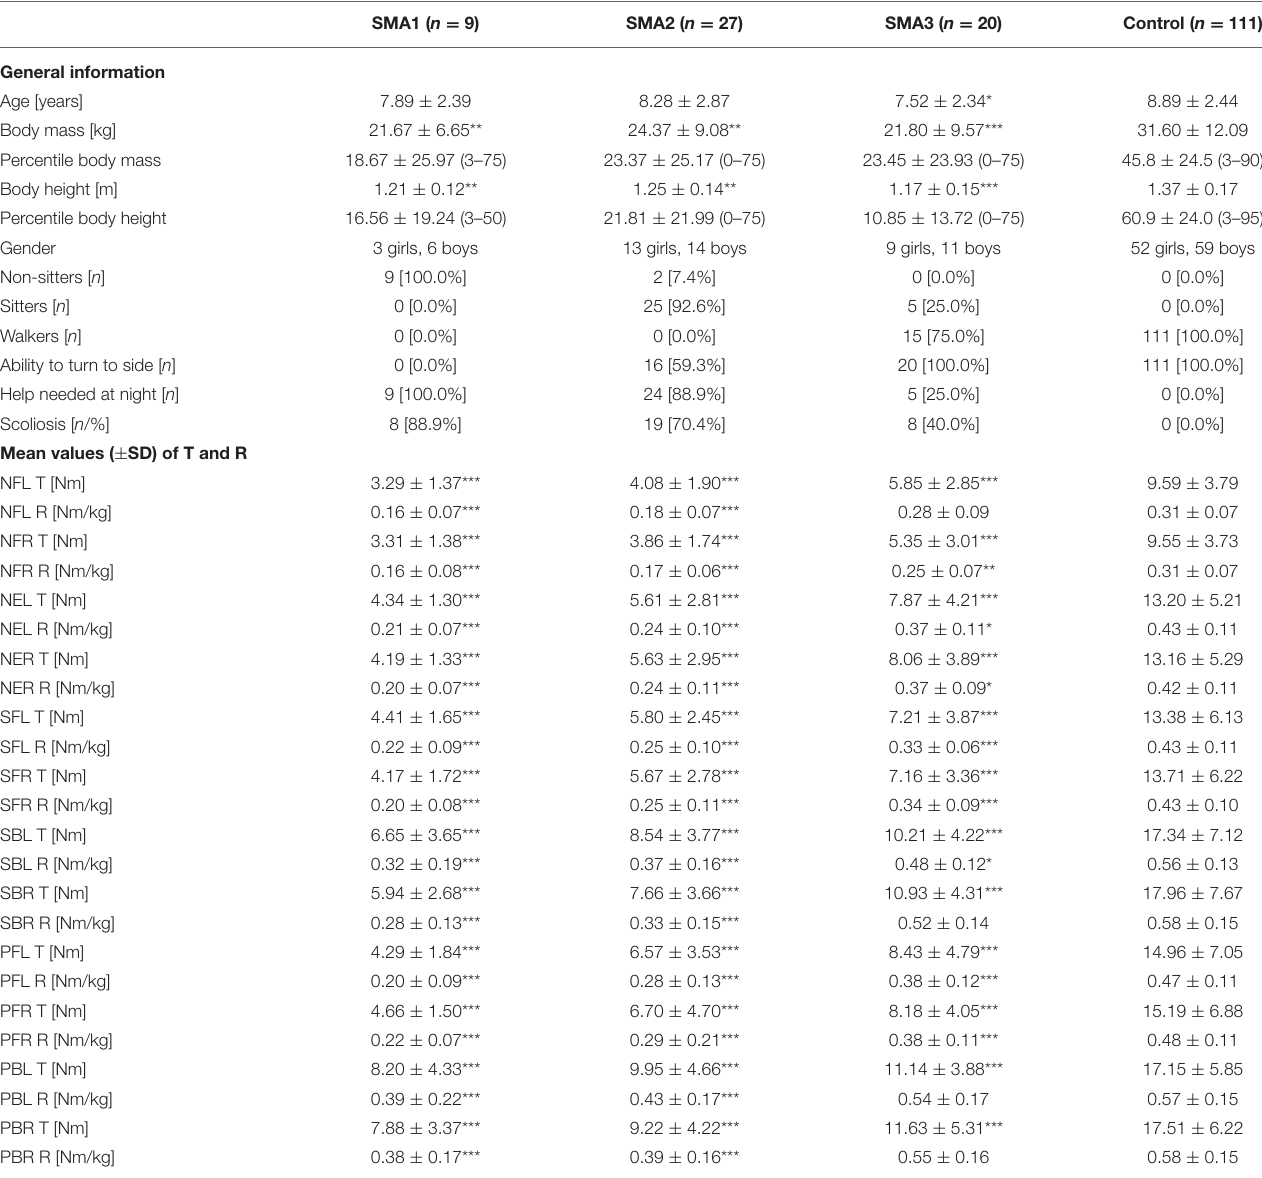
TABLE 2 | Characteristic of participants aged